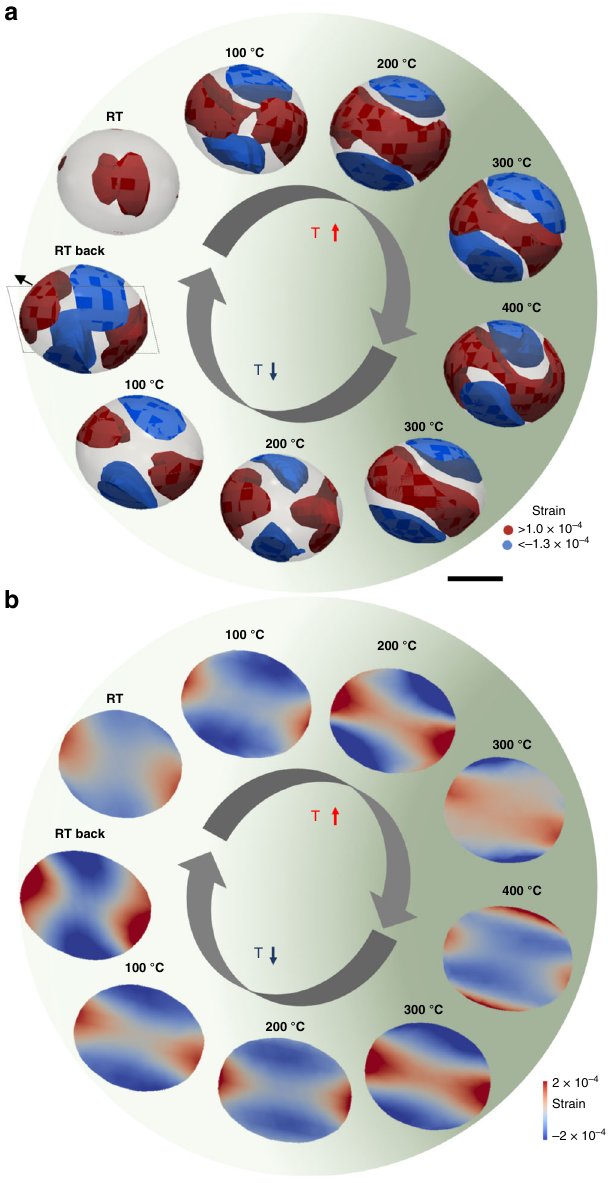
Fig. 4 Operando 3D strain images of gold cuboctahedron crystal. a Strain images (strain fi eld projected along (111)) for the highly compressive and tensile strain distribution of the same AuNP1 nanoparticle during CO oxidation reaction at RT, 100, 200, 300 and 400°C, during heating and cooling steps. Highly compressive (blue, strain < − 0.00013) and tensile (red, strain>0.00010) strain regions present anisotropic patterns. The particle shape is shown as a semi-transparent grey isosurface. b Corresponding particle cross-sections views of the internal strain fi eld at the dashed line box in ( a ). Scale bar, 30 nm. The green gradient is illustrating the increase/decrease of catalytic activity with the temperature simultaneously followed by mass spectrometry to the BraggCDI